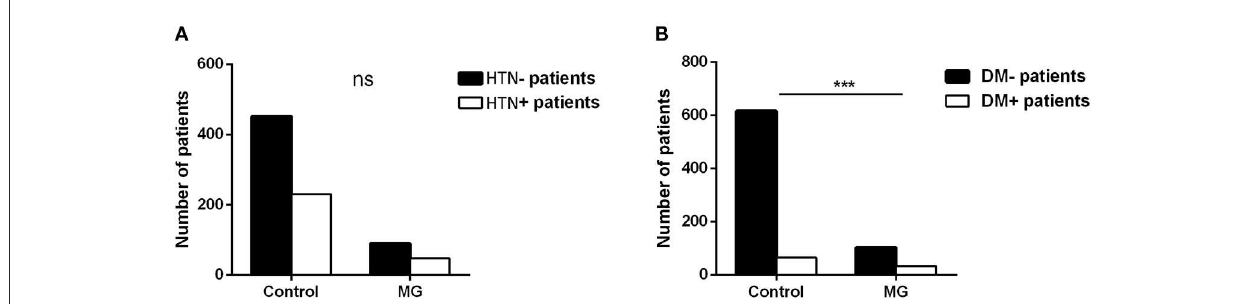
FIGURE2 HTN and T2DM prevalence (A, B) between 676 control people and 136MG patients (the controls of the same sex and age in the same period were randomly sampled from the physical examination system to match MG inpatients in the same hospital; t -test, *** P < 0.001).